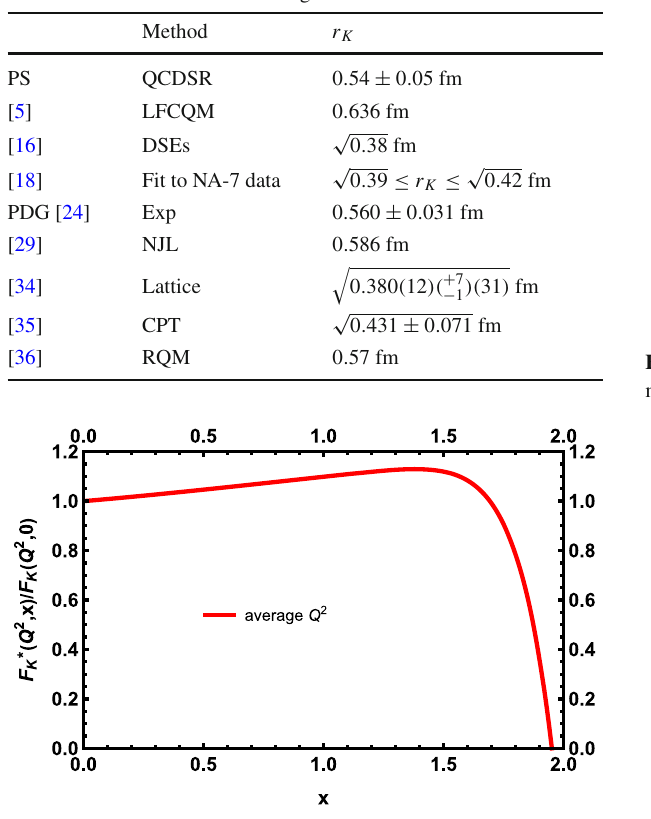
Table 3 Experimental result and theoretical predictions of different methods for the kaon vacuum charge radius